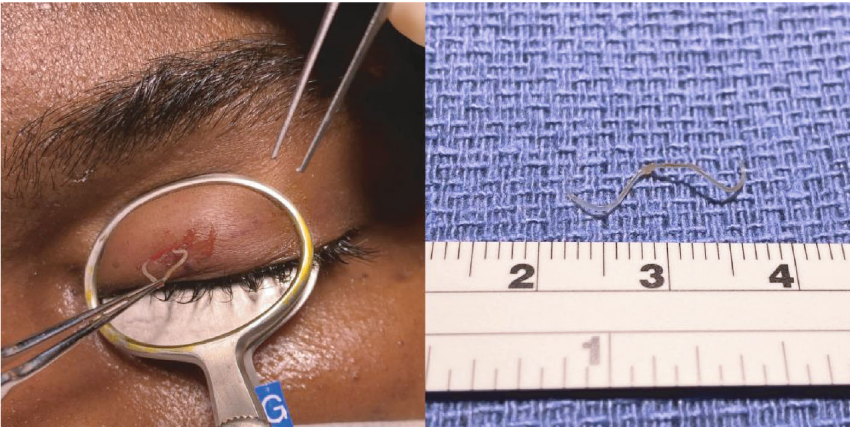
Figure 2: Surgical extraction of male adult Loa loa worm from the left upper eyelid and gross specimen at right which measured 3.2cm from head to